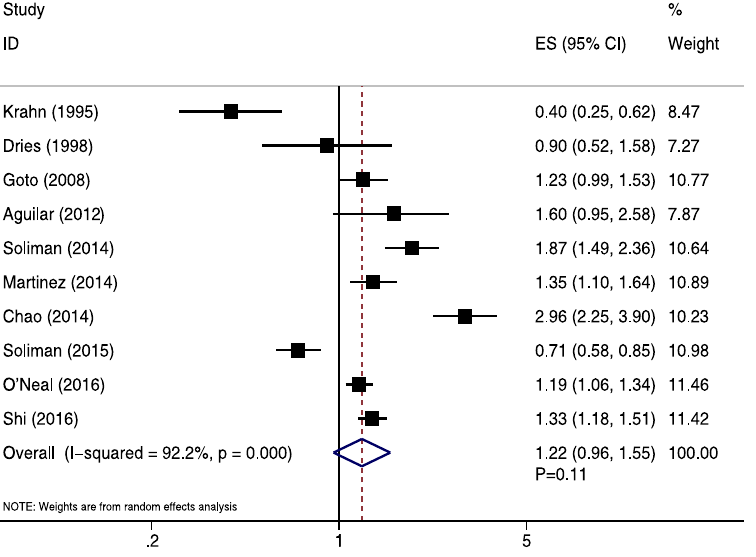
Figure 2. Forest plot showing the comparison between AF and non-AF patients in the pooled analysis of crude relative risk for myocardial infarction.